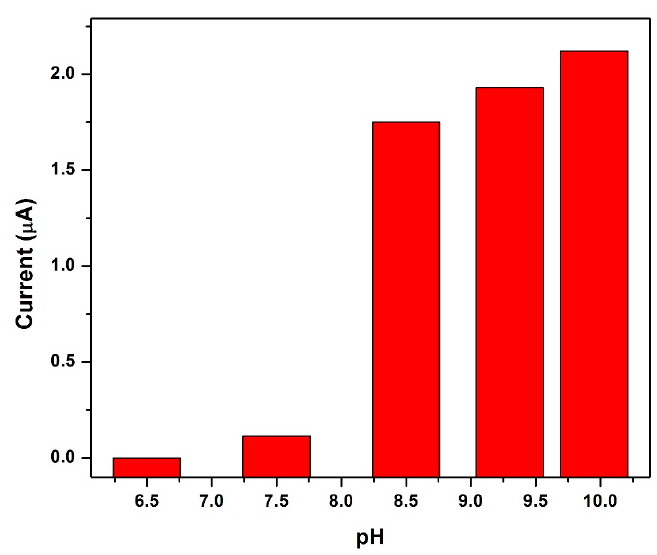
Figure 14. Dependence of electrolyte pH on the stripping peak currents of Ni 2+ at the NGr-DMG-GCEs in 0.1 M NH 3 /NH 4 Cl buffer as electrolyte solution.